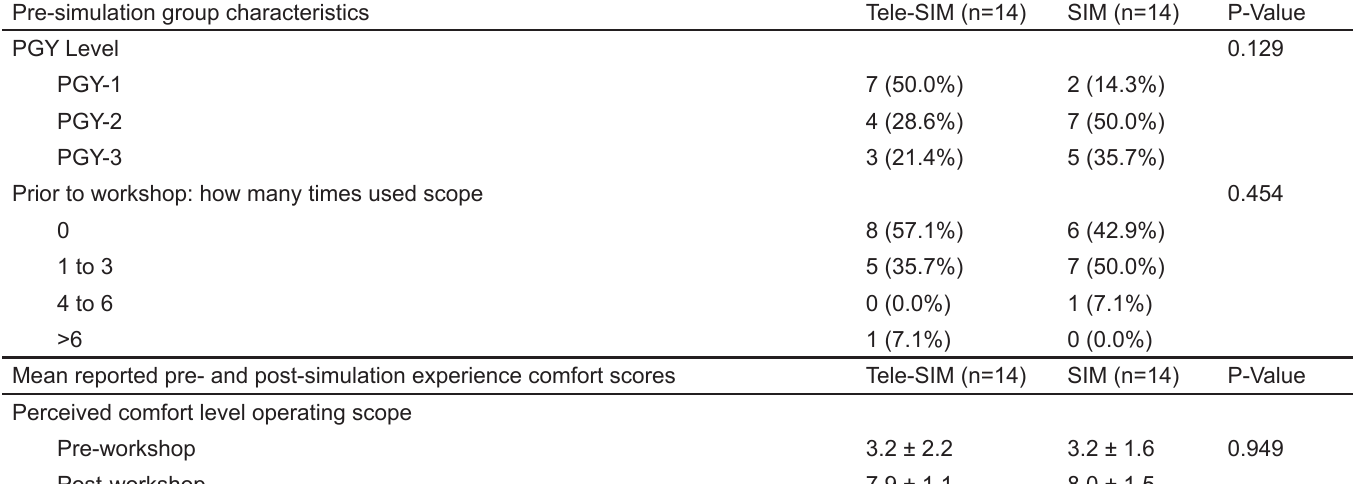
Table. Group characteristics and pre- and post-simulated reported experiences.